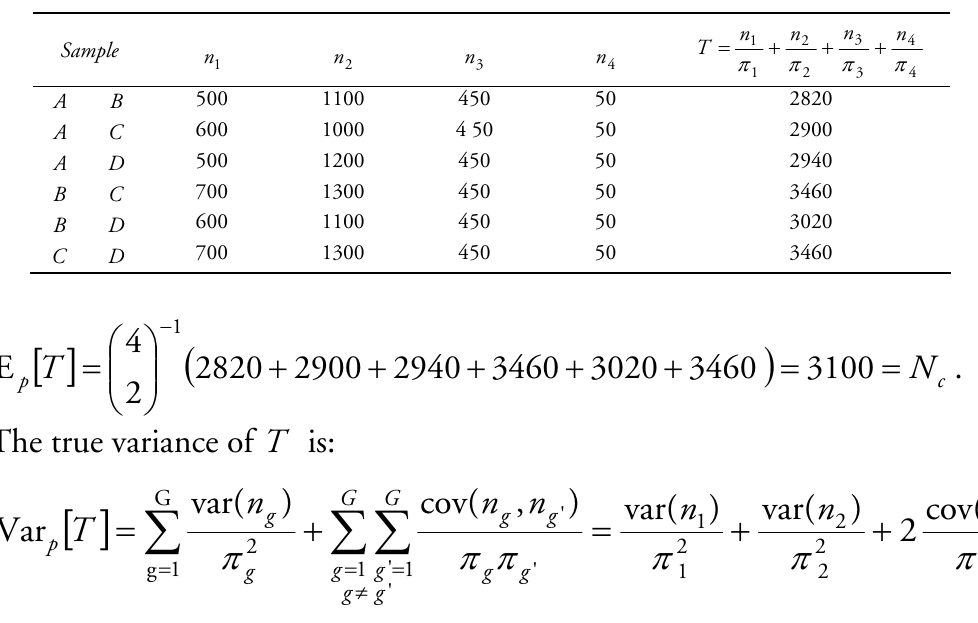
Sampling distribution of the size estimator T